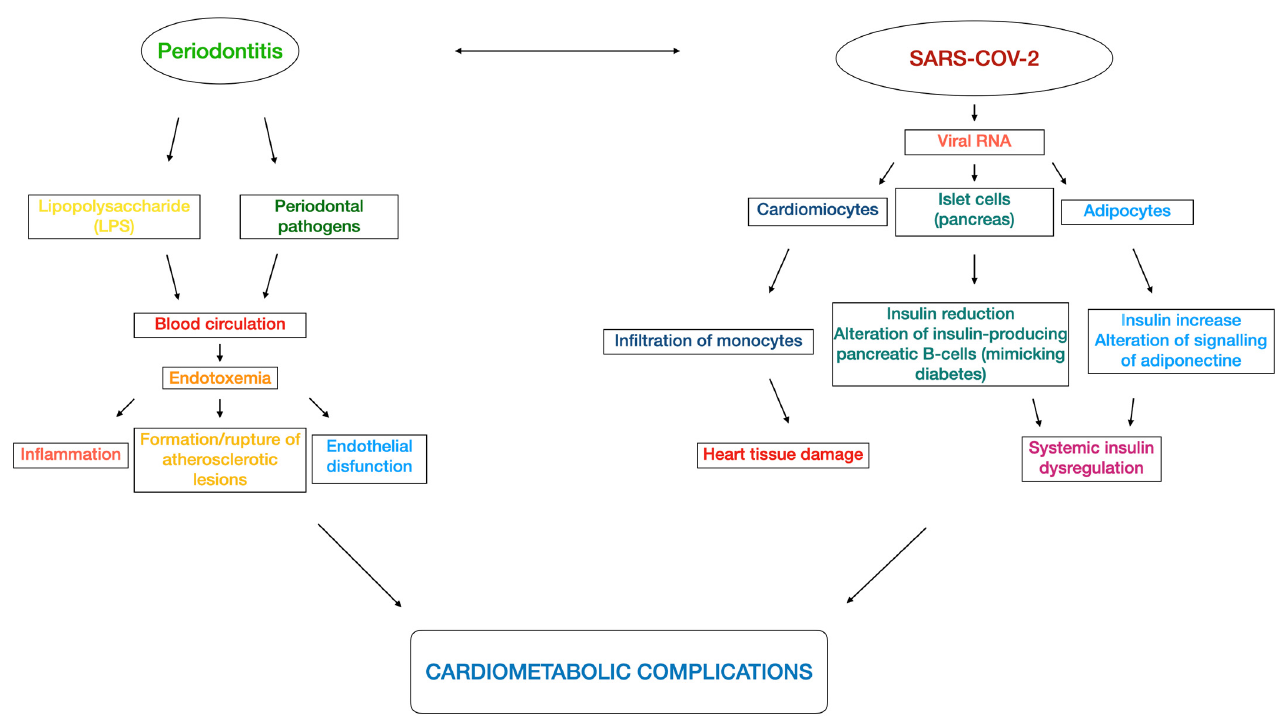
Figure 2. Flowchart of the several perio-COVID pathways that might lead to cardiometabolic im- pairments.